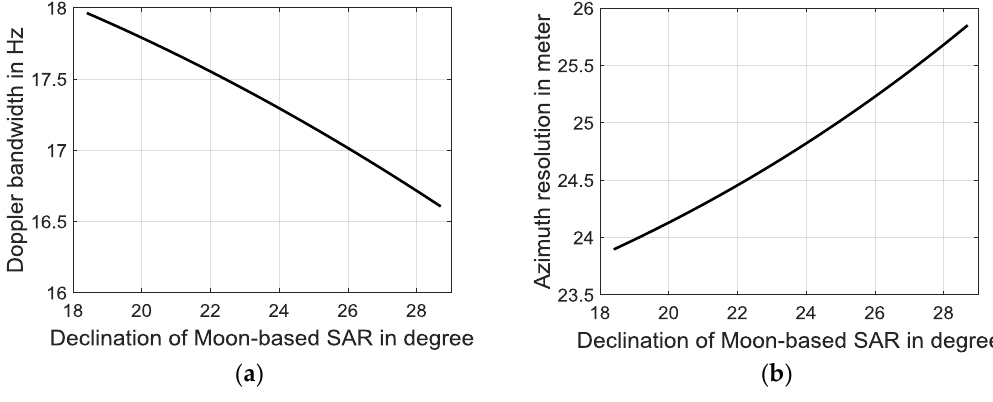
Figure 2. ( a ) Relationship between Doppler bandwidth and Moon-Based SAR’s declination; ( b ) Azimuth resolution as a function of the Moon-Based SAR’s declination. (2) Effects of ground target’s latitude.